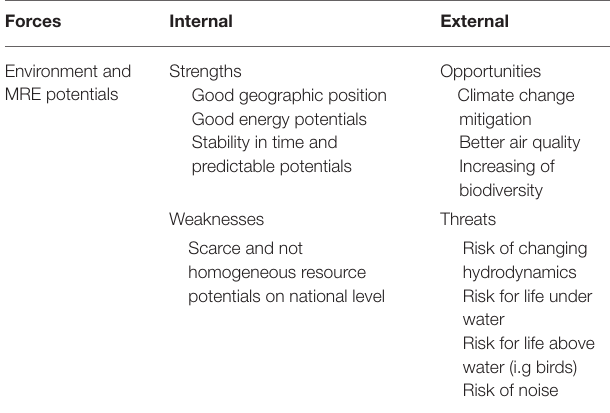
TABLE 2 | SWOT analysis of economic and funding factors.